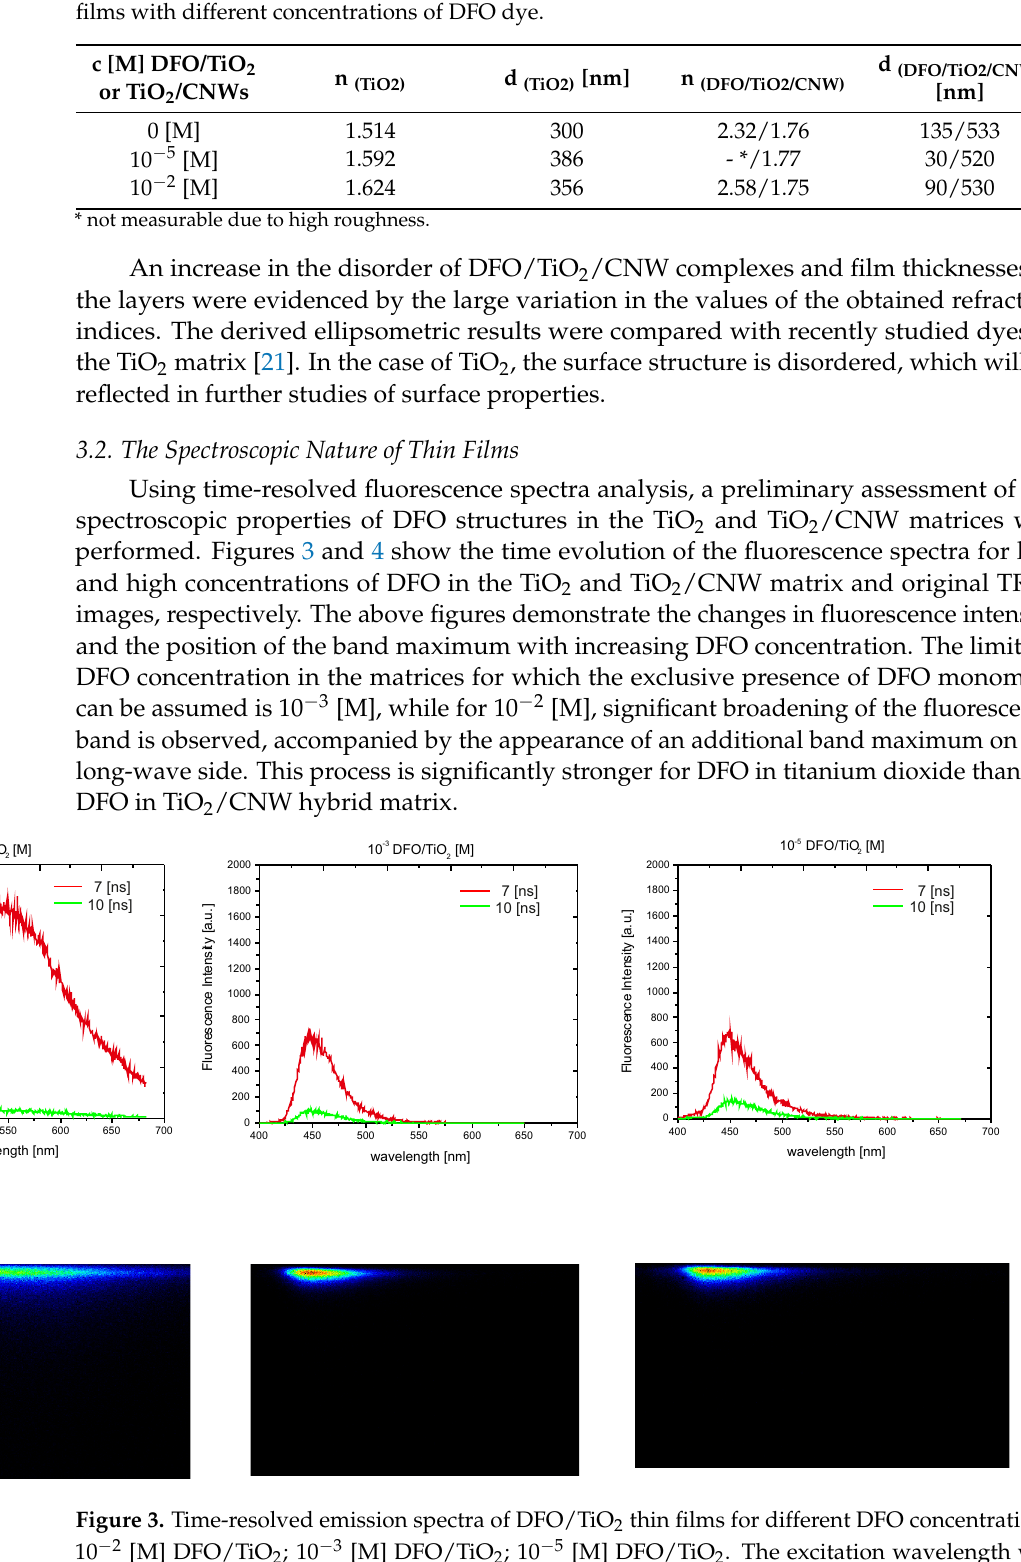
d (DFO/TiO2/CNW) [nm]